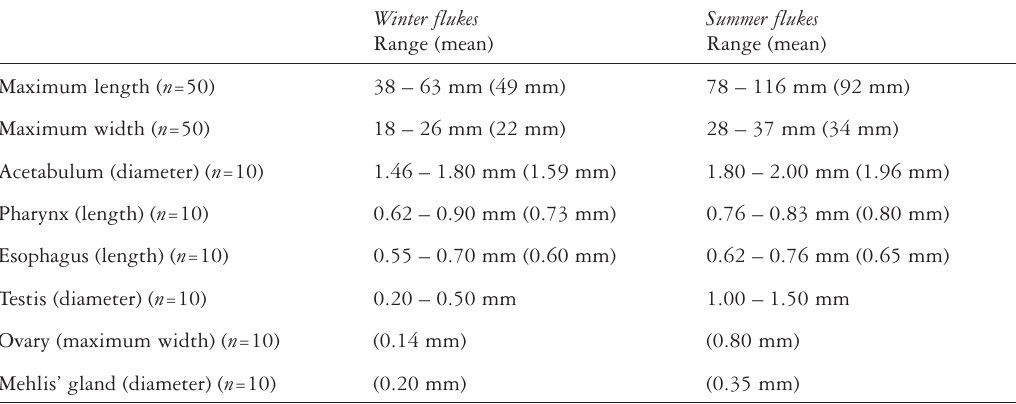
Table 1. Seasonal changes in morphology of rumen flukes ( Paramphistomum leydeni ) from reindeer in Finland. Specimens collected in winter (December-January) are referred to as winter flukes and specimens collected in summer (May-August) as summer